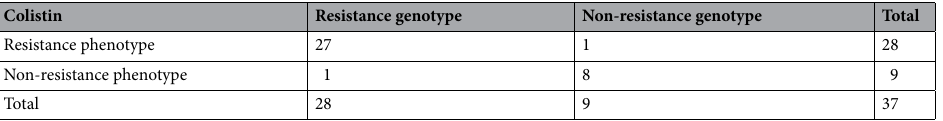
Table 4. Comparison between genotypes and phenotypes of colistin resistance using mPCR and MIC assays from 37 E. coli isolates, which are based on the resistance breakpoints according to CLSI (VET01S, M100) guidelines.